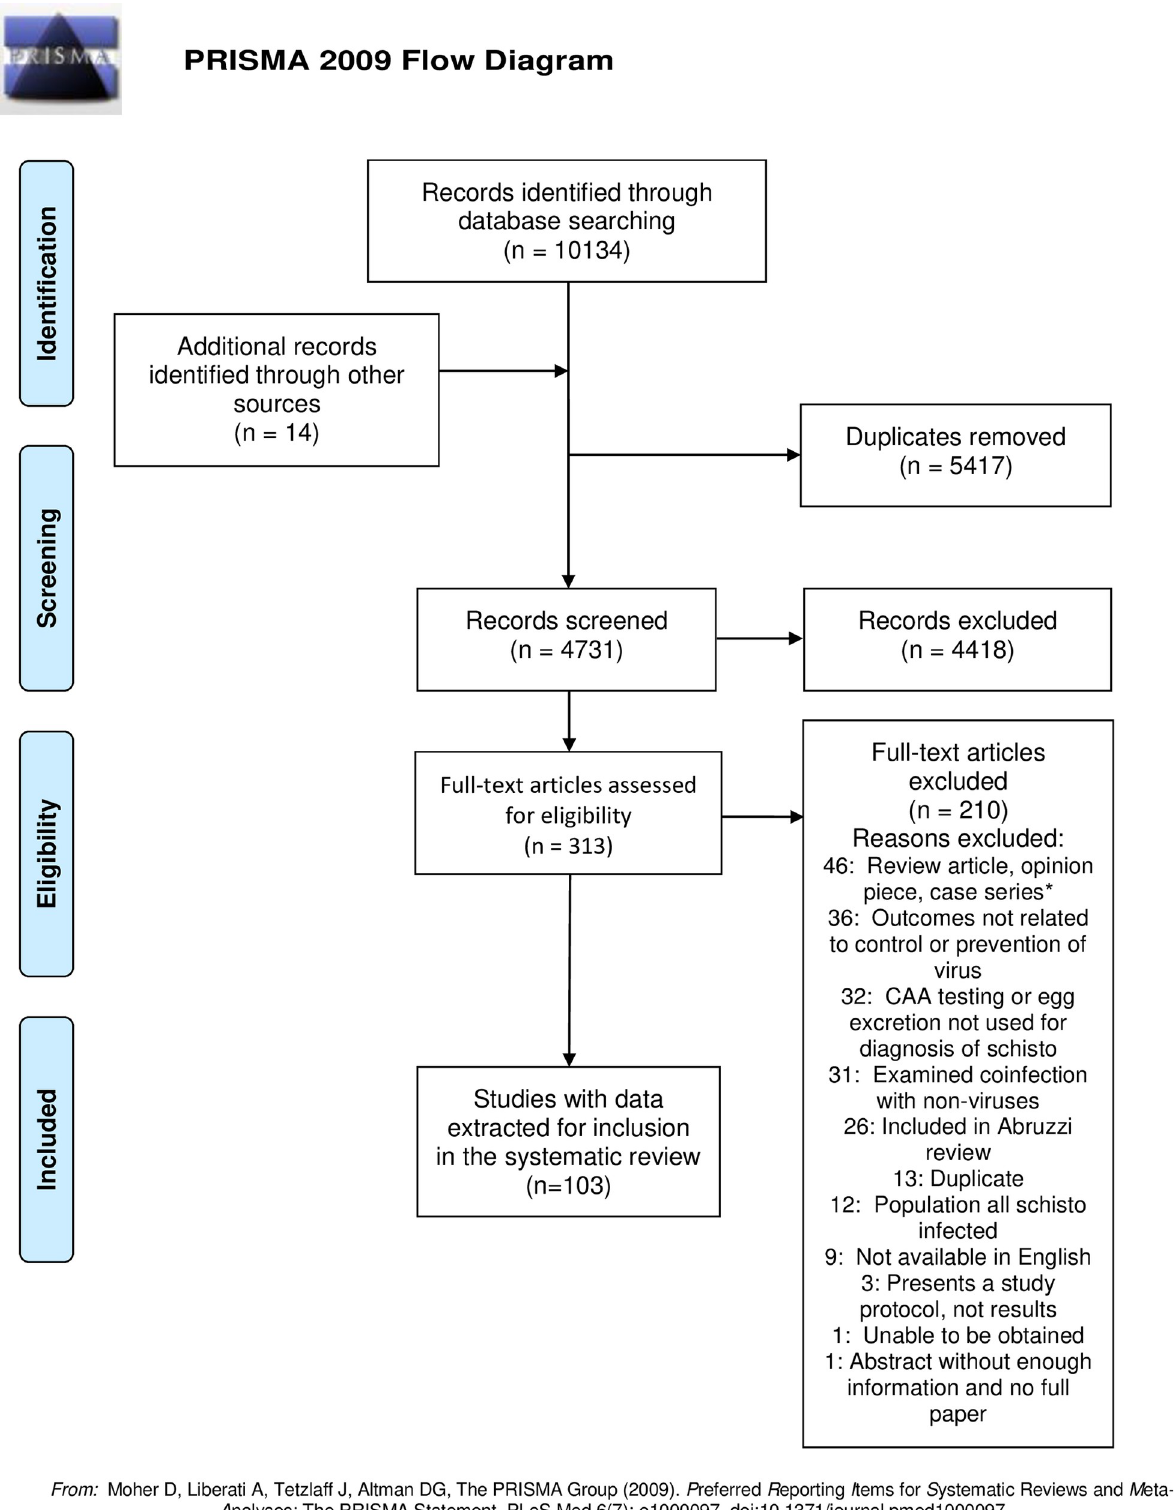
Fig 1. PRISMA flow diagram showing records identified by searching, screened, assessed for eligibility, and included in the systematic review.